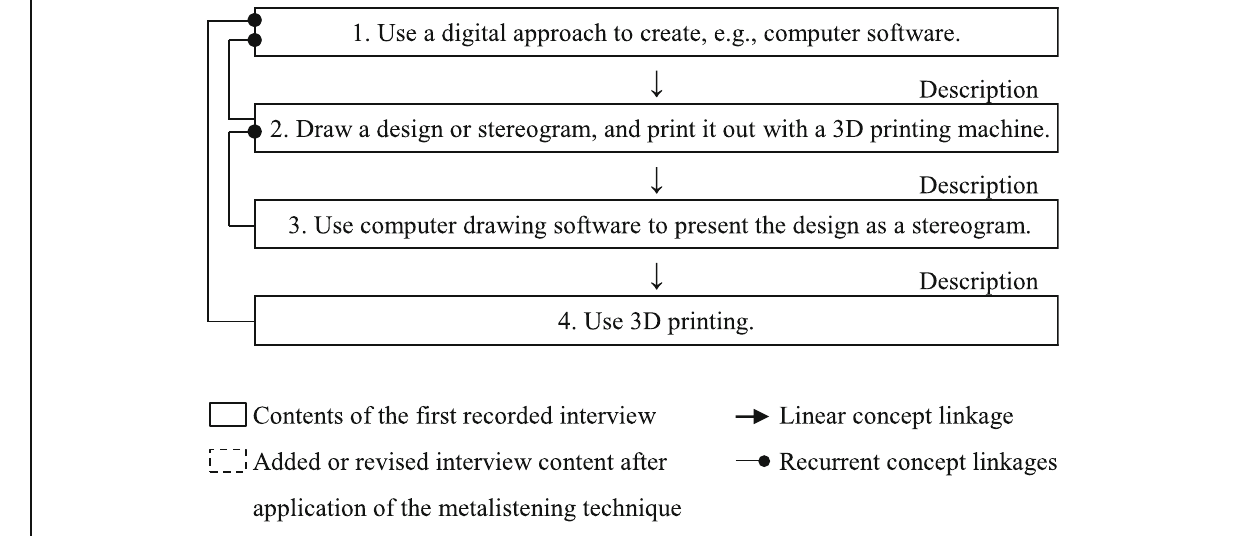
Fig. 3 PS6 ’ s flow map: pretest interview